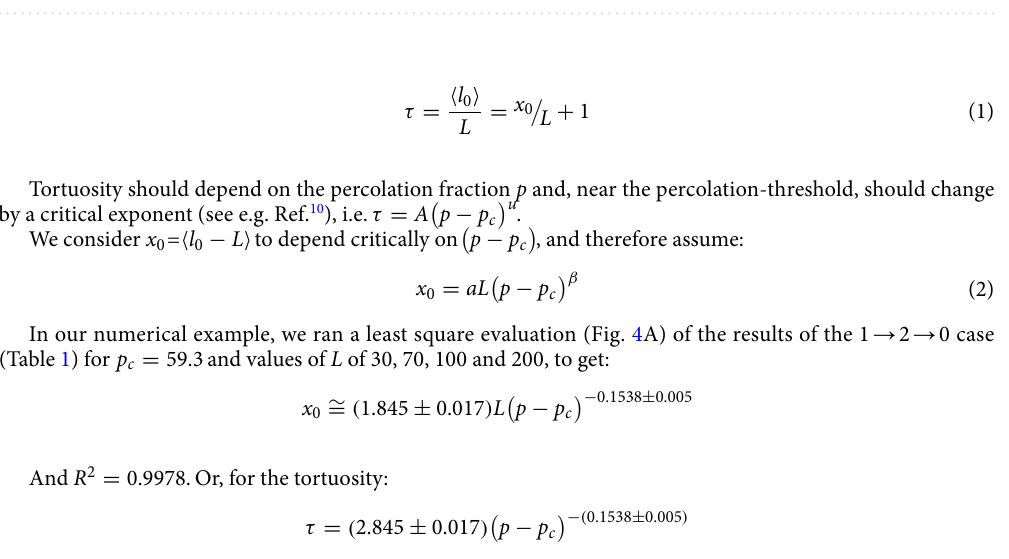
Figure 2. (Colors on line) Percolation curves for the four cases. Red (circles)—the 1 → 0 case. Green (triangles)—the 1 → 2 → 0 and the FFM cases. Blue (squares)—the " diagonal " unidirectional